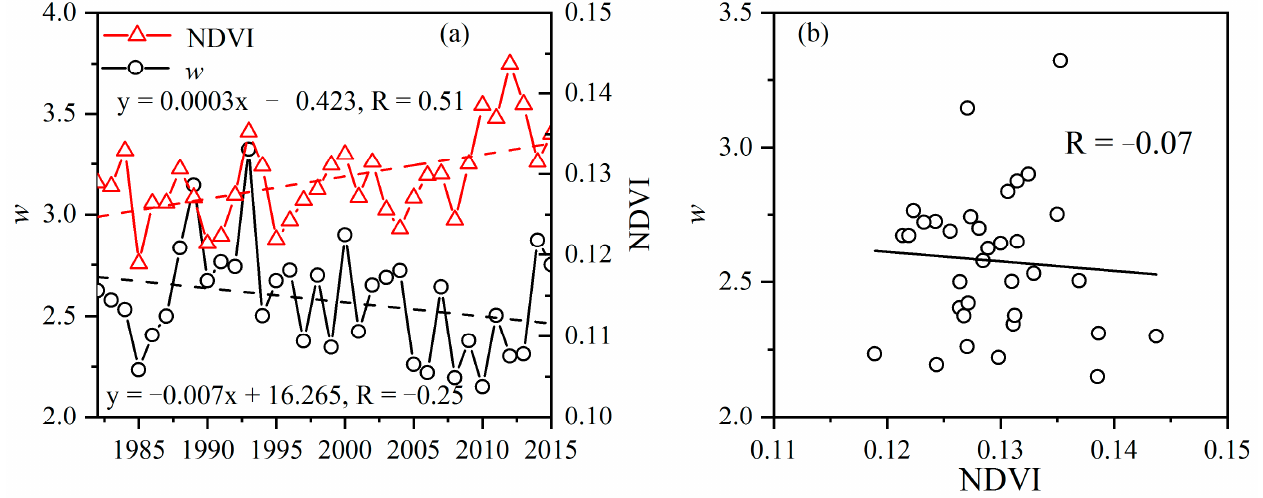
Figure 8. Variations in controlling parameter w and NDVI ( a ); and relationship between w and NDVI ( b ) from 1982 to 2015.